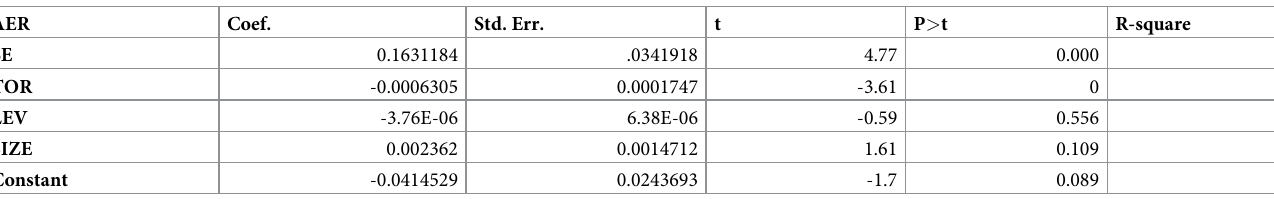
Table 5. Shannon fixed effect